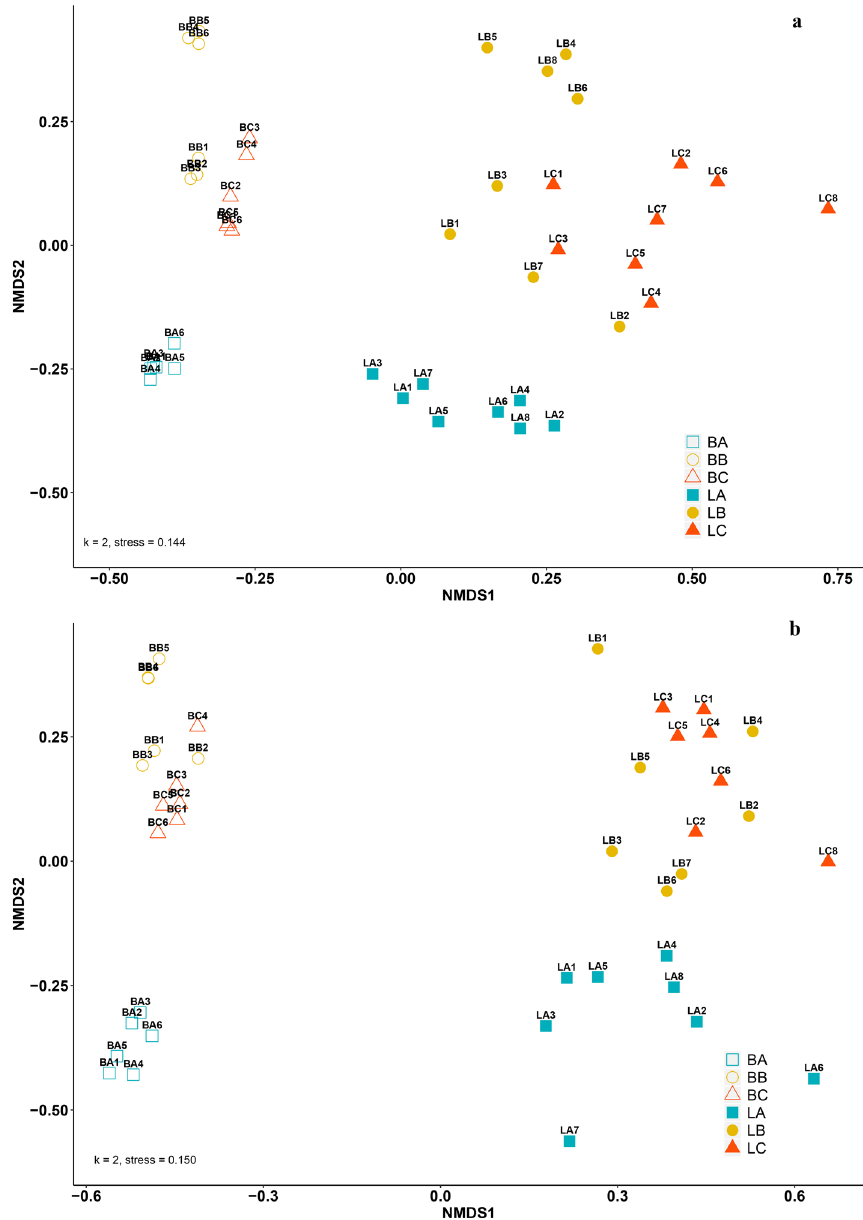
Figure 4. Non-metric multidimensional scaling (NMDS) plot displaying β-diversity by Bray–Curtis dissimilarities for ( a ) prokaryotic and ( b ) fungal communities. Non-filled symbols show bulk soils (B), filled symbols show rhizosphere samples of L. decidua (L). Letters (A, B, C) indicate the site replicates and numbers represent the respective replicates within fraction, site and light treatment (e.g. BA1 stands for the community in bulk soils at forest site A and sample replicate 1). Numbers in bulk soils 1, 2, 3 stand for normal light and 4, 5, 6 for intensified light conditions. Numbers in rhizosphere samples 1, 3, 5, 7 indicate intensified light and 2, 4, 6, 8 normal light